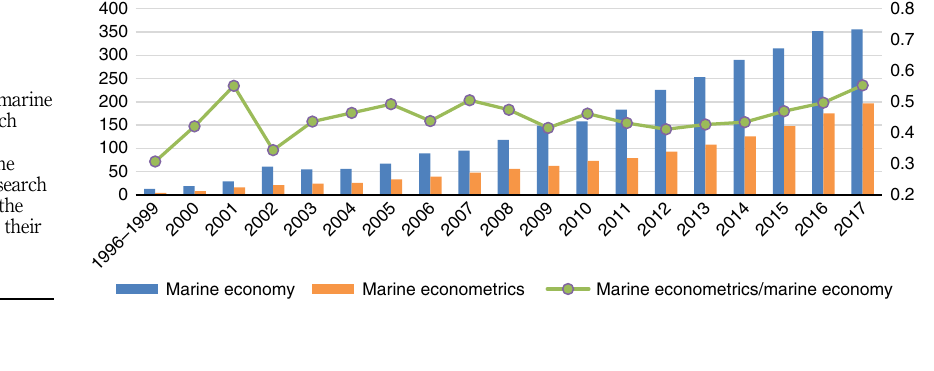
Figure 4. The number of marine